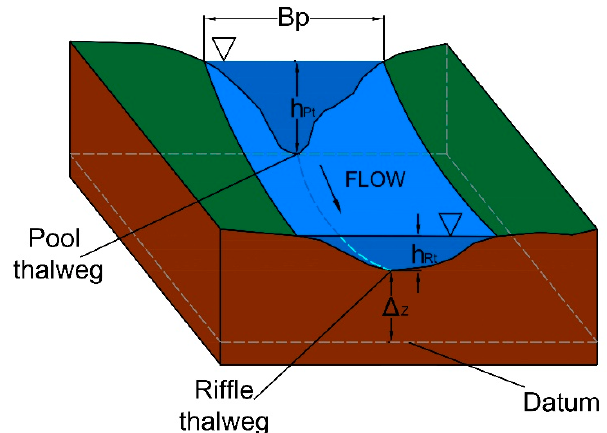
Figure 2. Pool-riffle structure and the geometric variables considered in the analysis (modified from Caamaño et al. [47]). Table 2. Considered residual pool